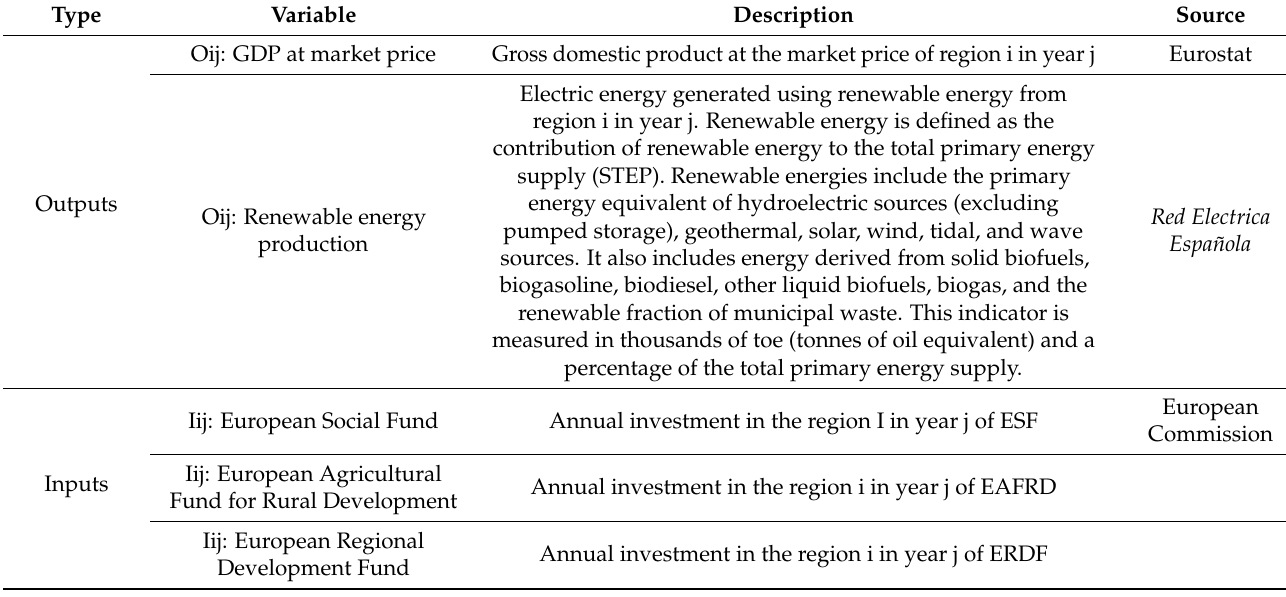
Table 3. The production function of the degree of environmental efficiency.